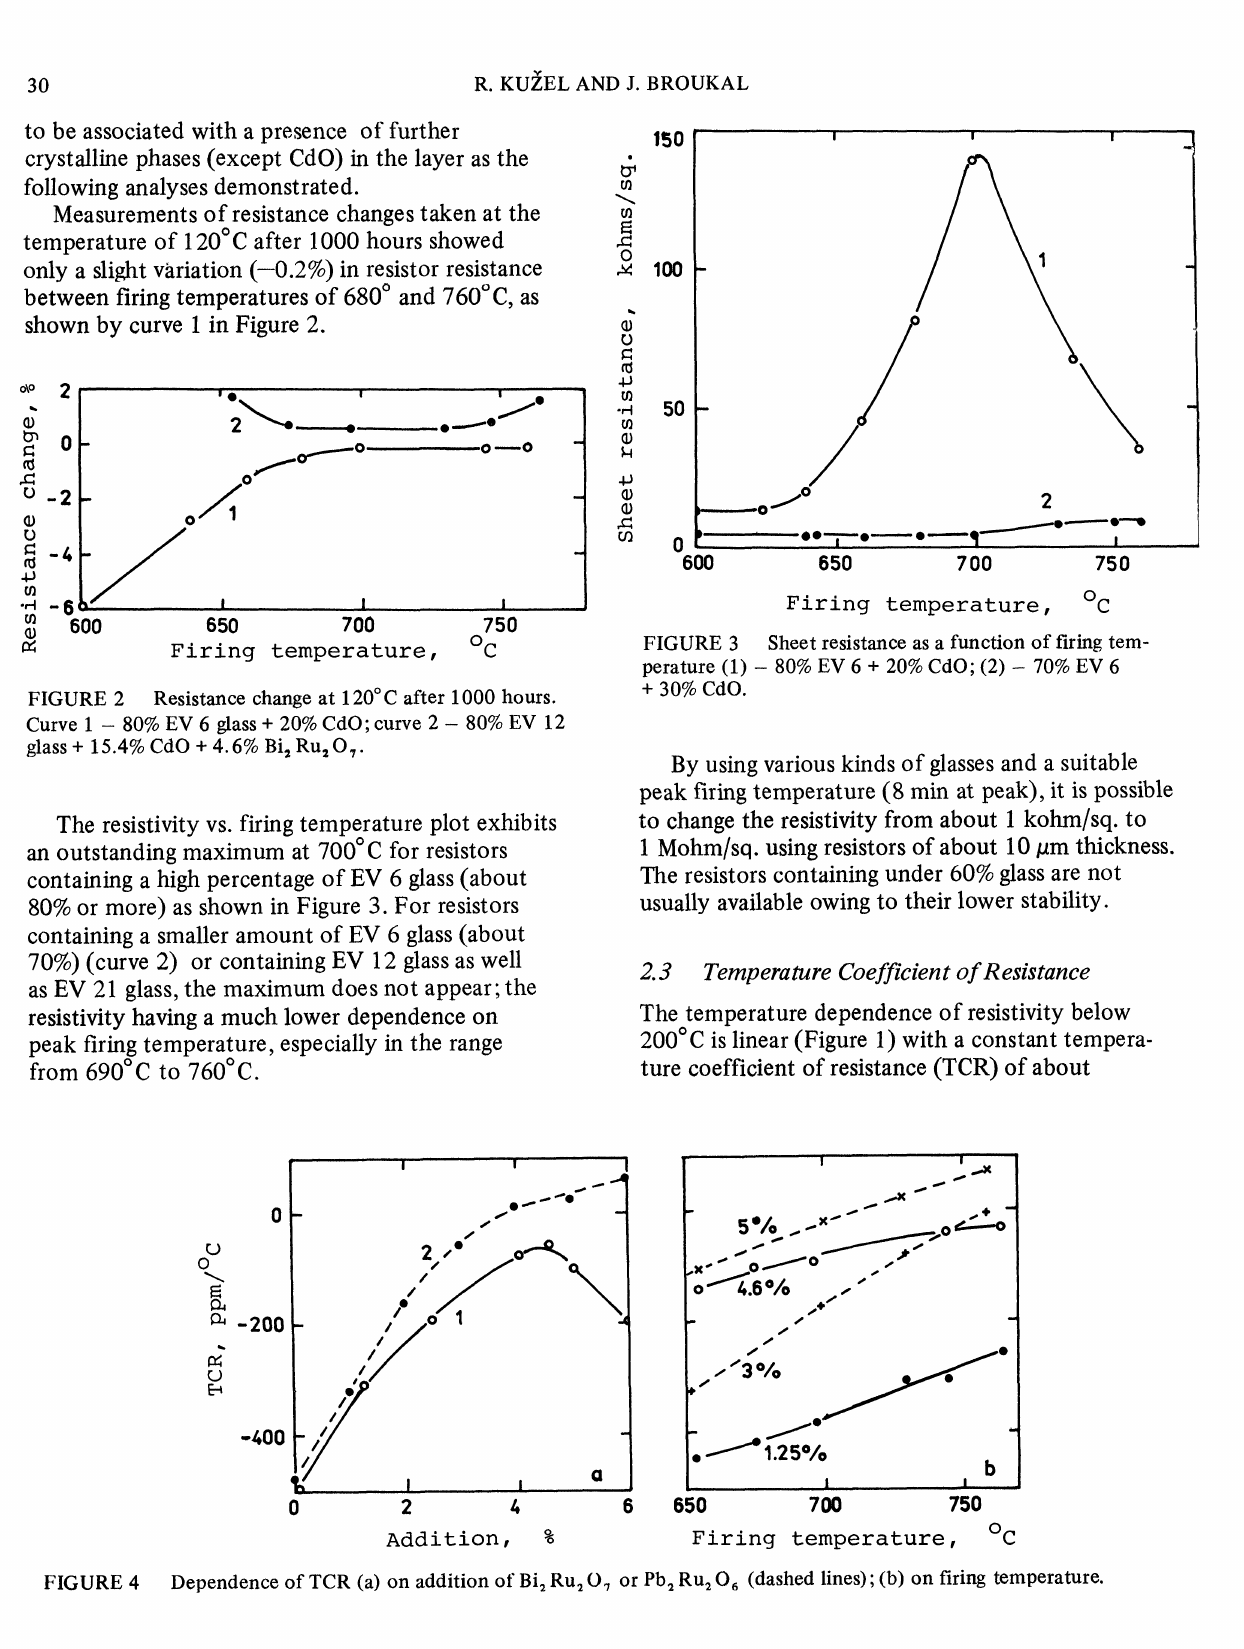
FIGURE 4 Dependence of TCR (a) on addition of Bi Ru O or Pb Ru 20 (dashed lines); (b) on firing